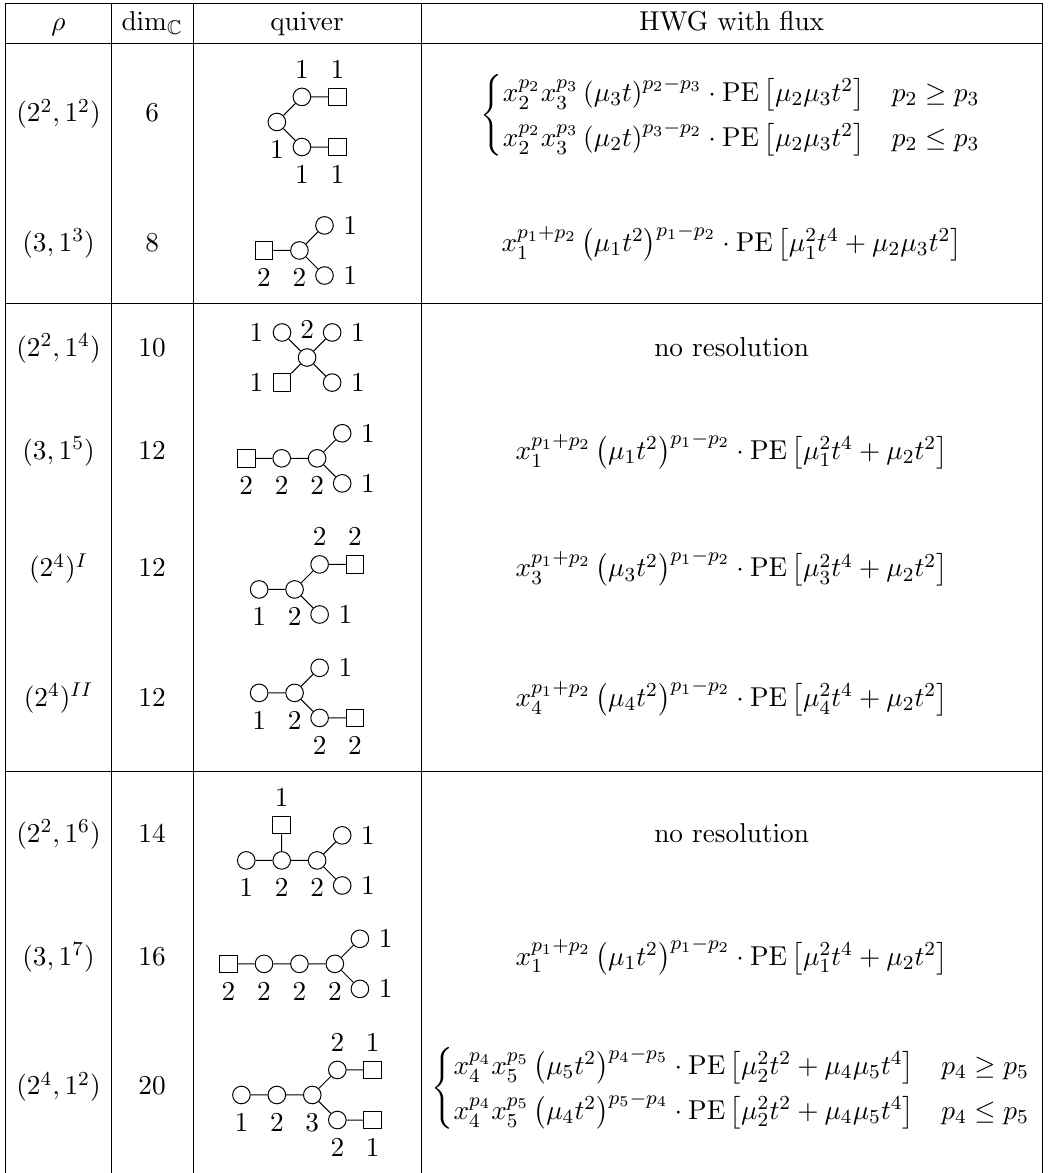
Table 6 . Coulomb branch quiver gauge theories for D -type algebras: realisations of the (closures of the) nilpotent orbits of height 2 for D n with n = 3 ; 4 ; 5. To eliminate the unphysical U(1) in G F one repeats the earlier arguments. Introducing an auxiliary fugacity z 0 for U(1) (cid:26) G F , and P Q n j p j imposing z z r i = 1, with r i the ranks of the gauge nodes, leads to the following cases: 0 i i =1 x 1 = 1 for (3 ; 1 2 n (cid:0) 3 ), x n (cid:0) 1 x n = 1 for (2 n (cid:0) 1 ; 1 2 ) and n = odd, and x n (cid:0) 1 = 1 or x n = 1 for (2 n ) and n = even (and z 0 (cid:17) 1).